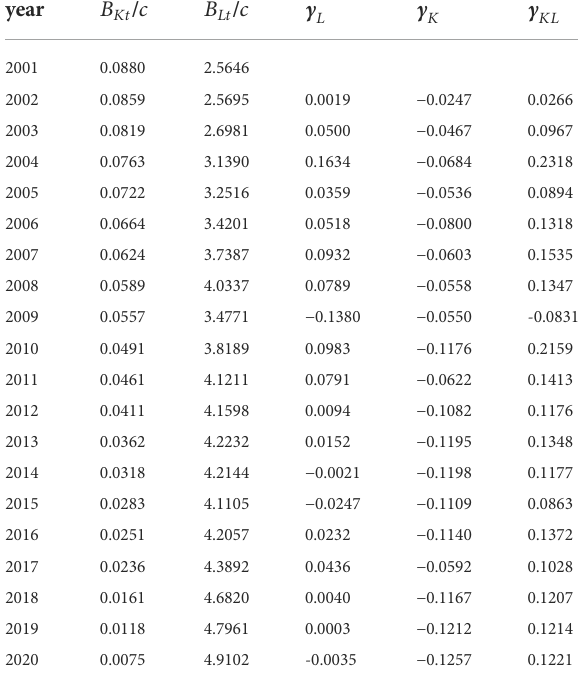
TABLE 3 The result of γ